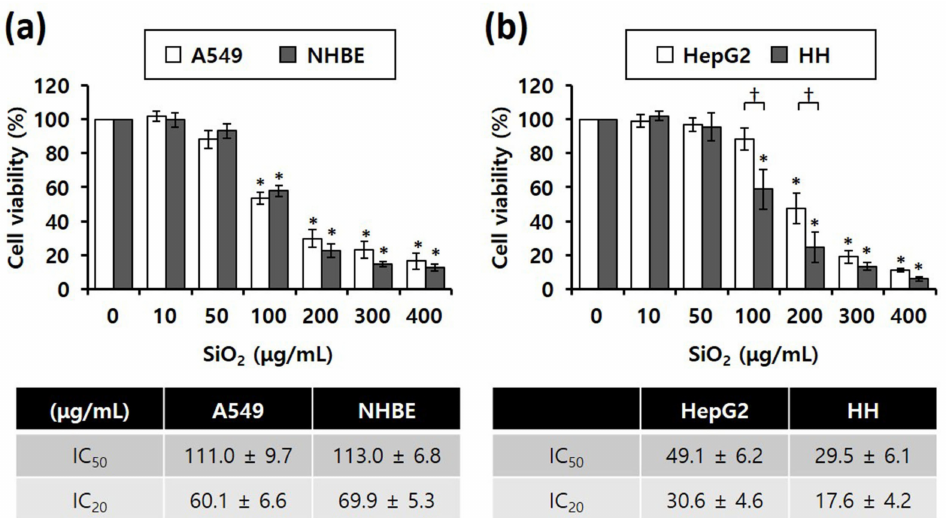
Figure 2. MTS cytotoxicity assay results showing the different inhibitory concentrations of 20 nm SiO 2 NPs against cells subjected to NP treatment for 4 h (total number of replicates = 12); ( a ) Lung-derived cells. * p < 0.005, compared with untreated cells. ( b ) Liver-derived cells. * p < 0.005, compared with untreated cells; † p < 0.05, compared with HepG2